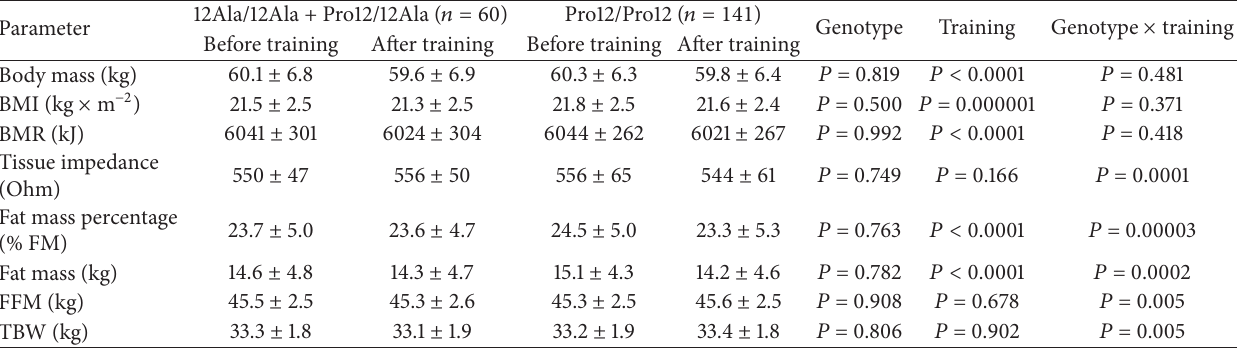
Table 1: PPARG genotypes and response to training (analyzed by two-way mixed ANOVA test).